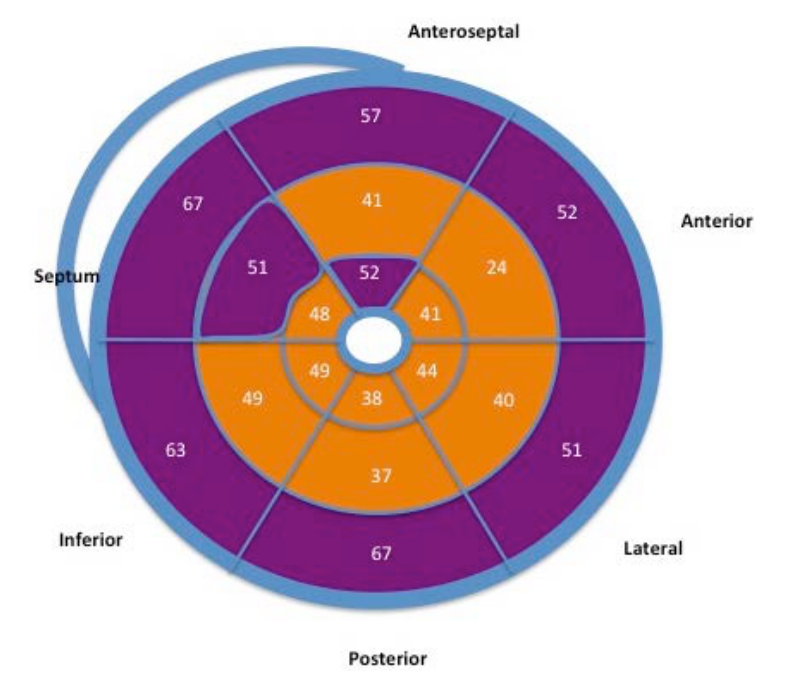
Figure 3. Bull’s eye map showing the frequency of PSS (%) in the different segments.